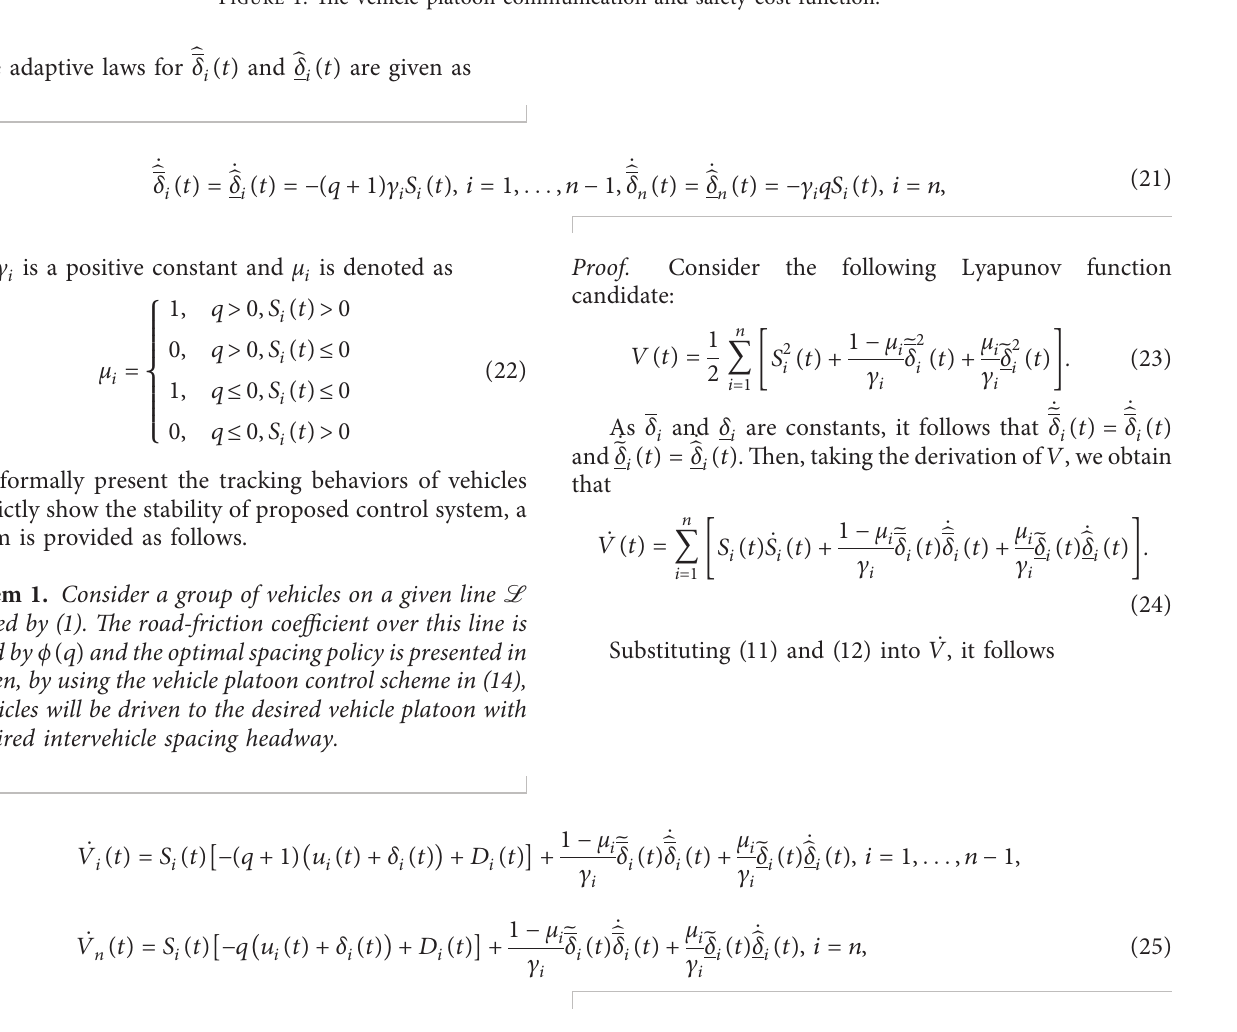
Figure 1: The vehicle platoon communication and safety-cost